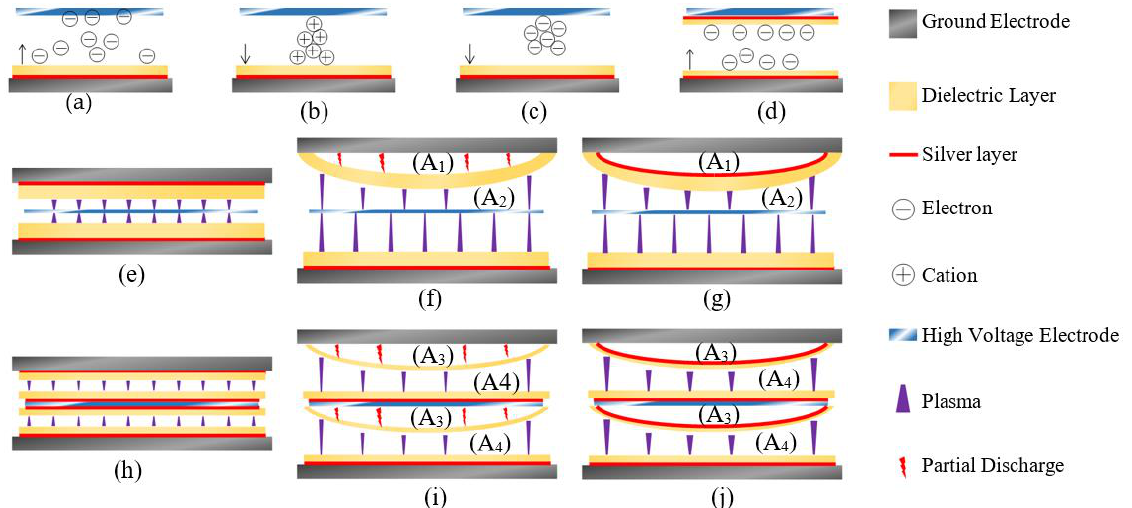
Figure 10. Schematic diagram of the mechanism of silver layer to improve discharge intensity. ( a ) schematic diagram of the electronic avalanche in SDBOR; ( b ) schematic diagram of the streamer in SDBOR; ( c ) schematic diagram of the glow corona discharge in SDBOR; ( d ) schematic diagram of the electronic avalanche in DDBOR; ( e ) internal structure of SDBOR; ( f ) schematic diagram of the discharge in single dielectric layer DBD reactor without silver layer; ( g ) schematic diagram of the discharge in SDBOR; ( h ) internal structure of DDBOR; ( i ) schematic diagram of the discharge in double dielectric layer DBD reactor without silver layer; ( j ) schematic diagram of the discharge in DDBOR.